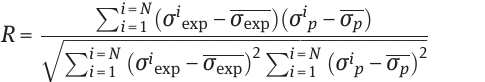
Note: “ Y ” represents presence; while “ N ” represents absence). Table 5: Strain rate sensitivity ( m ) value for ASS 304 and 315 alloys.